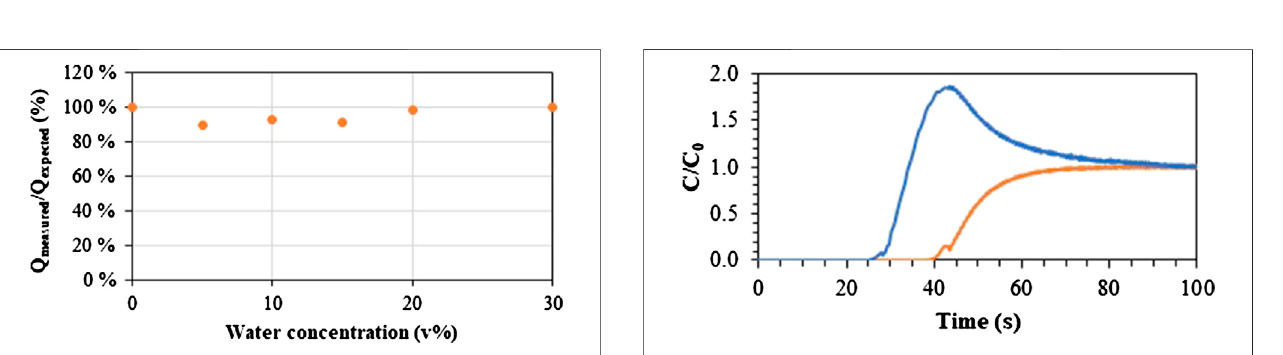
FIGURE 8 | Breakthrough curves at 26 ° C for separation of household waste stream biogas (60 v% CH 4 , 33 v% CO 2 , 7 v% air – 0.5 Nl/min). CH 4 (Blue) and CO 2